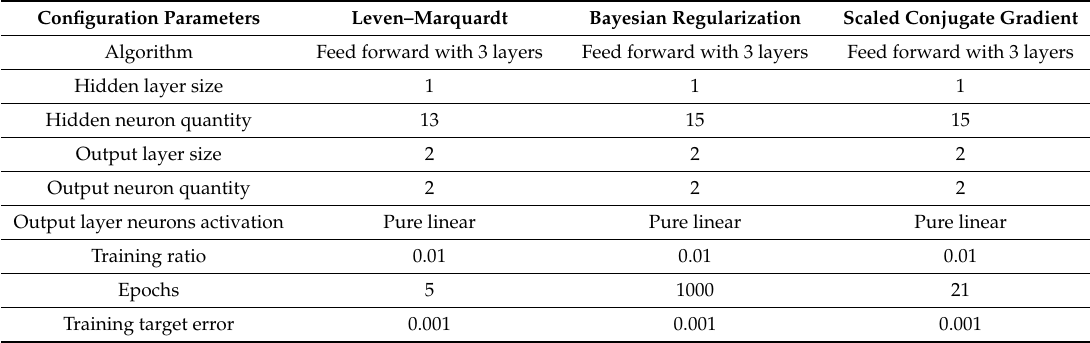
Table 4. Configuration parameters for the neural network